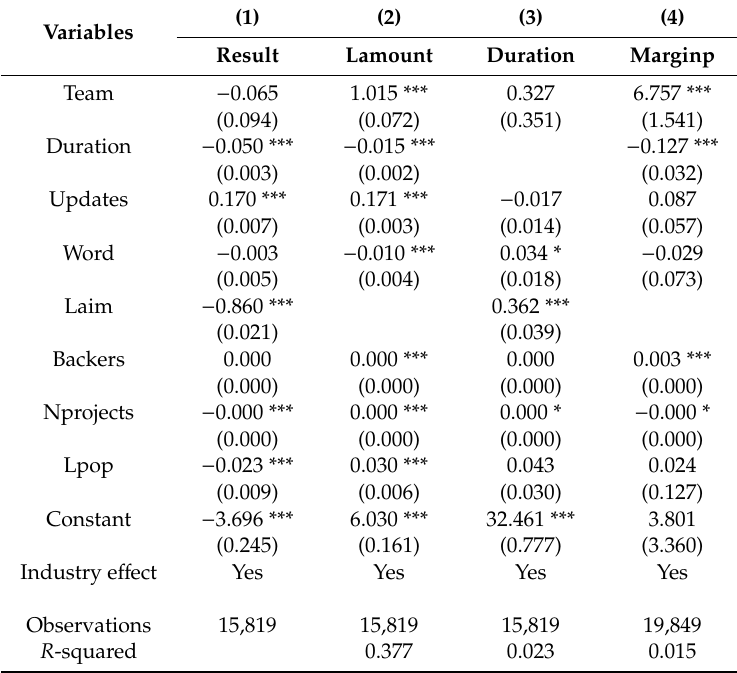
Table 9. U.S. team results. This table reports results of regression analysis of the success, amount raised, duration, and margin (%) variables when a U.S initiator is a team. We controlled for di ff erent variables. Table 3 defines all the variables.